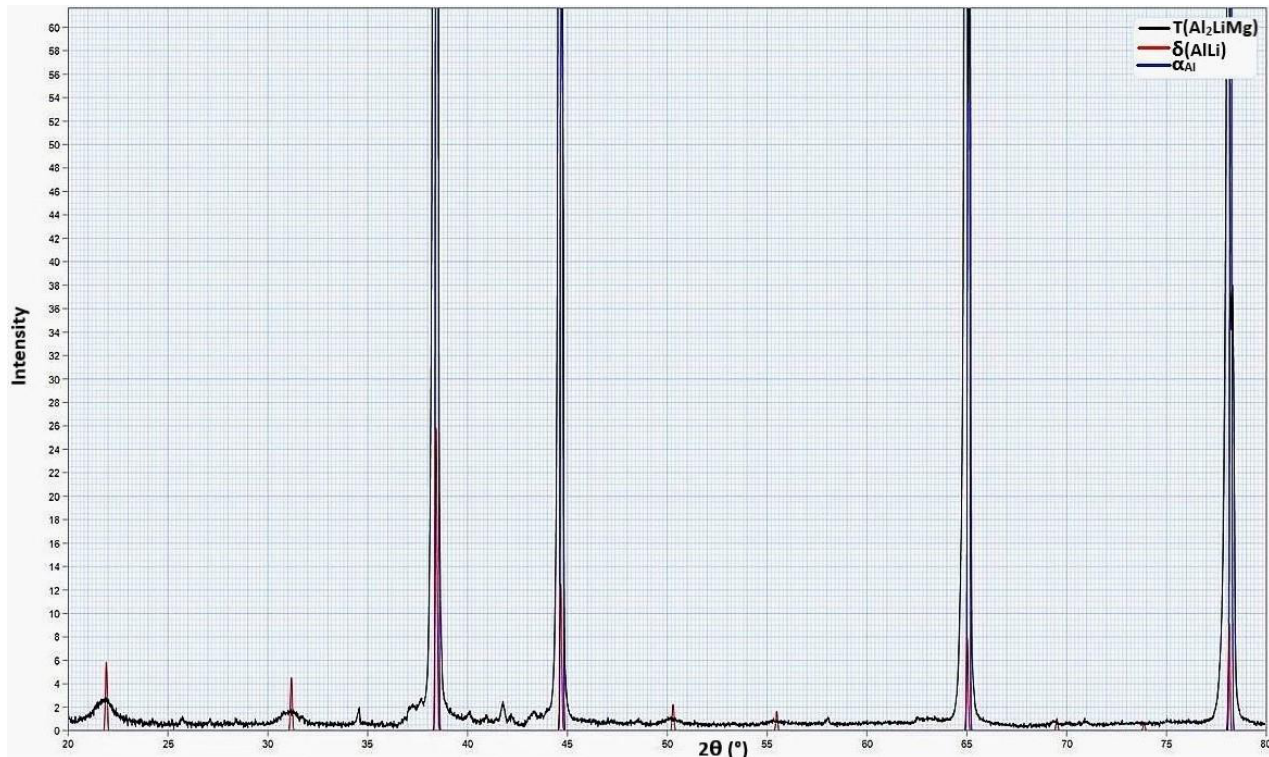
Figure 5. The X-Ray Diffraction (XRD) diffractogram of the sample in as-cast condition. The XRD of the sample in the as-cast condition identified the presence of the α Al matrix and the T and δ phases (Figure 5).